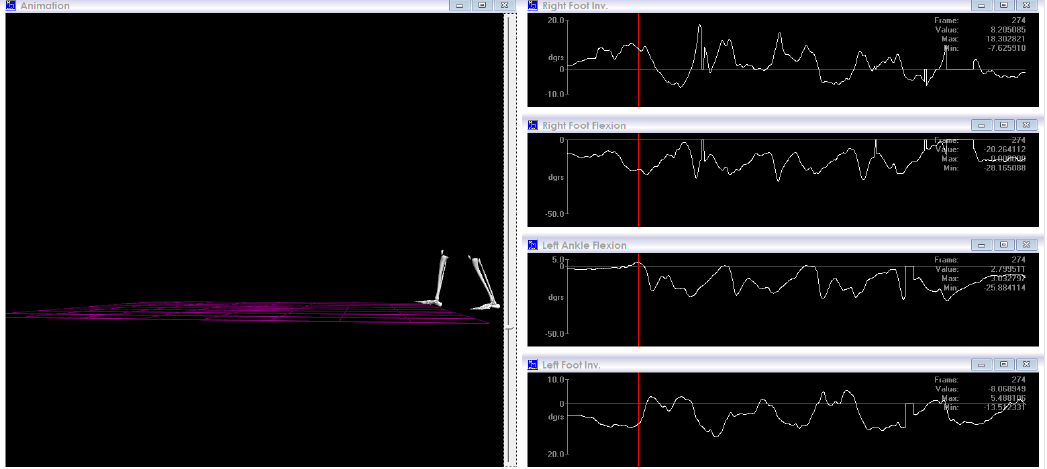
Figure 5. Example of MotionMonitor™ playback used to record right heel strike frame numbers. Pictured on the left is the frame where the first right foot heel strike occurs. On the right are examples of the graphs depicting the output of the motion capture measurements.